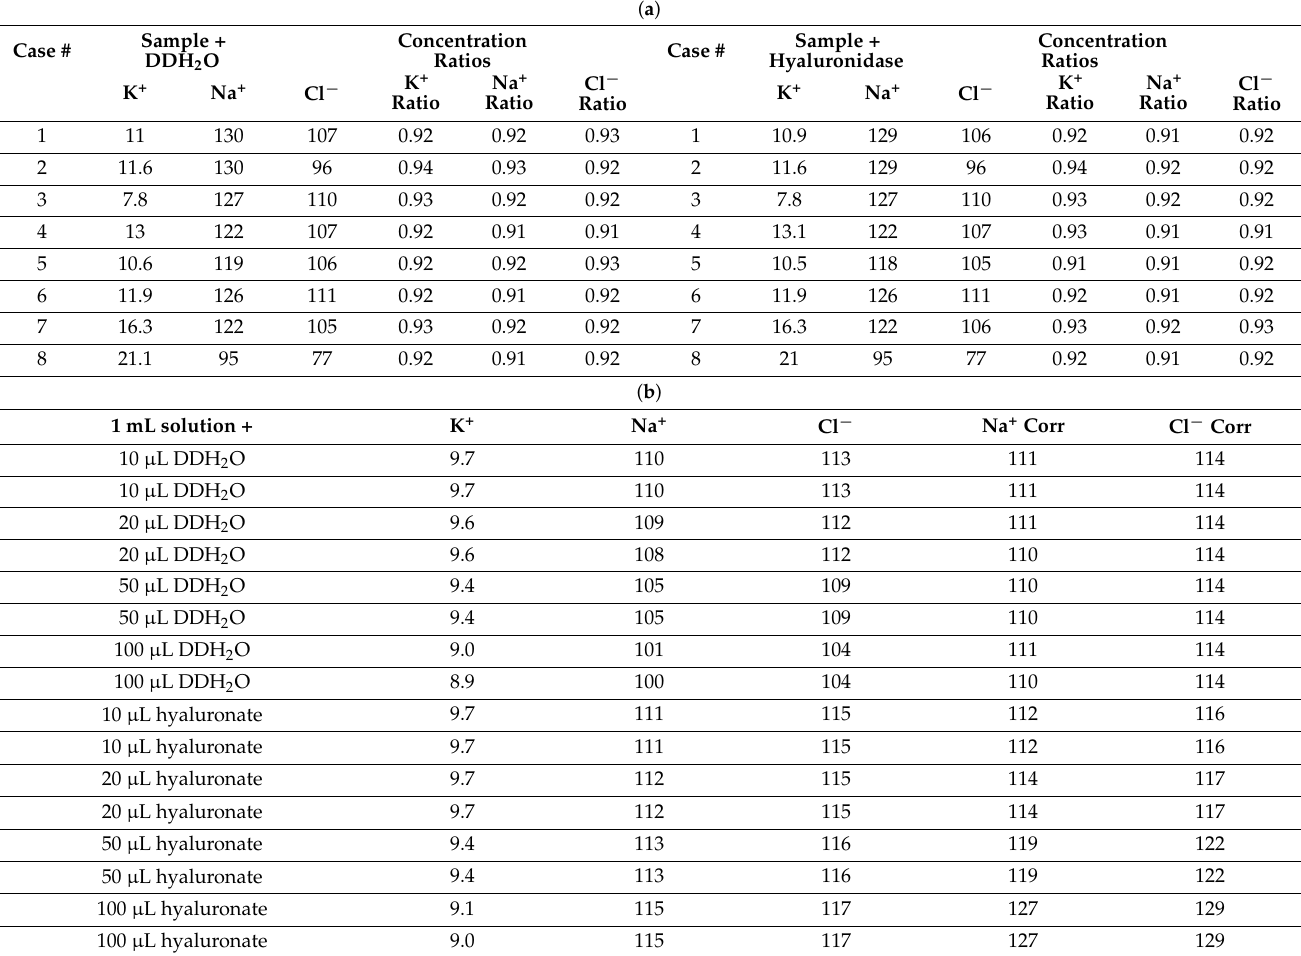
Table 3. Effect of addition of ( a ) hyaluronidase to postmortem vitreous samples and ( b ) sodium hyaluronate to water solutions of electrolytes.